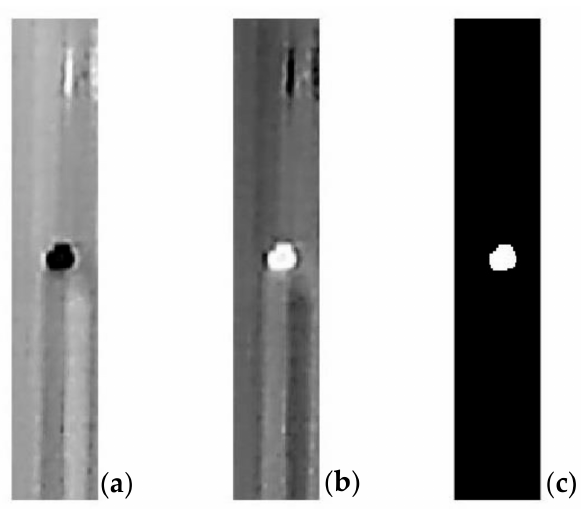
( c ) The binary image with a white blob corresponding to the plastic sphere.